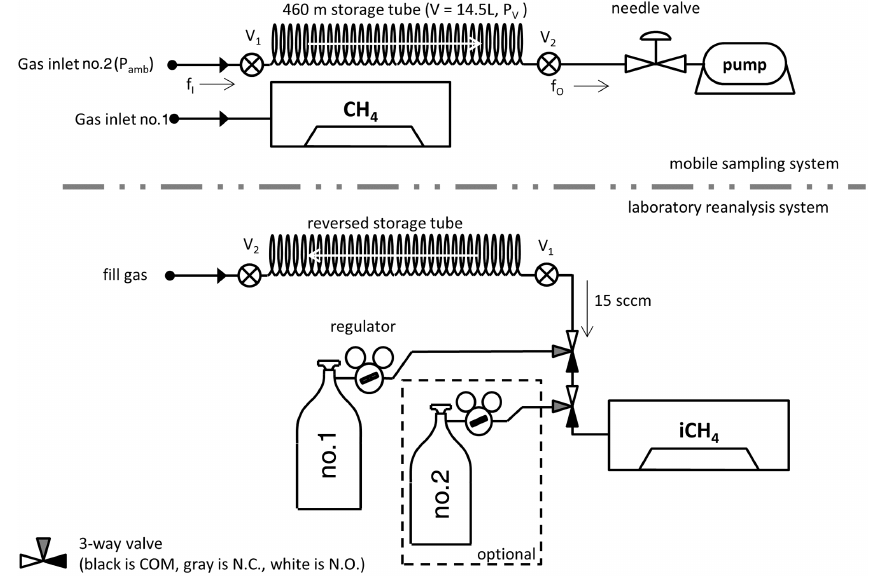
Figure 13. Apparatus for making regional isotope and ethane ratio measurements. The top schematic shows the mobile sampling system. The flow through the long storage tube is set by the pump and needle valve. The two manual valves (V 1 and V 2 ) are in the open position during the measurements, and closed when the survey is complete. An optional flow meter can be inserted in the line upstream of the storage tube to verify the actual flow into the instrument. An instrument in the vehicle measures the local ambient concentration on a separate inlet. The storage tube is transported to the laboratory (lower schematic), where the gas stored in the long tube is reanalyzed slowly (with the flow reversed, so the last gas in is the first out). The reanalysis is periodically interrupted to run one or more calibration standard. A gas drying system can be introduced downstream of the storage tube in the laboratory to reduce the possible effect of water vapor on the measurements, but this was not done in the results reported here. A fill gas other than ambient air can be used to denote the end of the